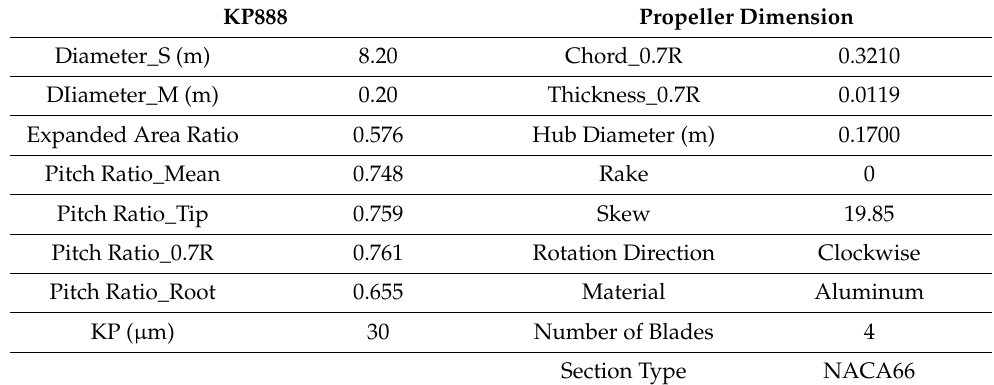
Table 12. Main dimension of target propeller.